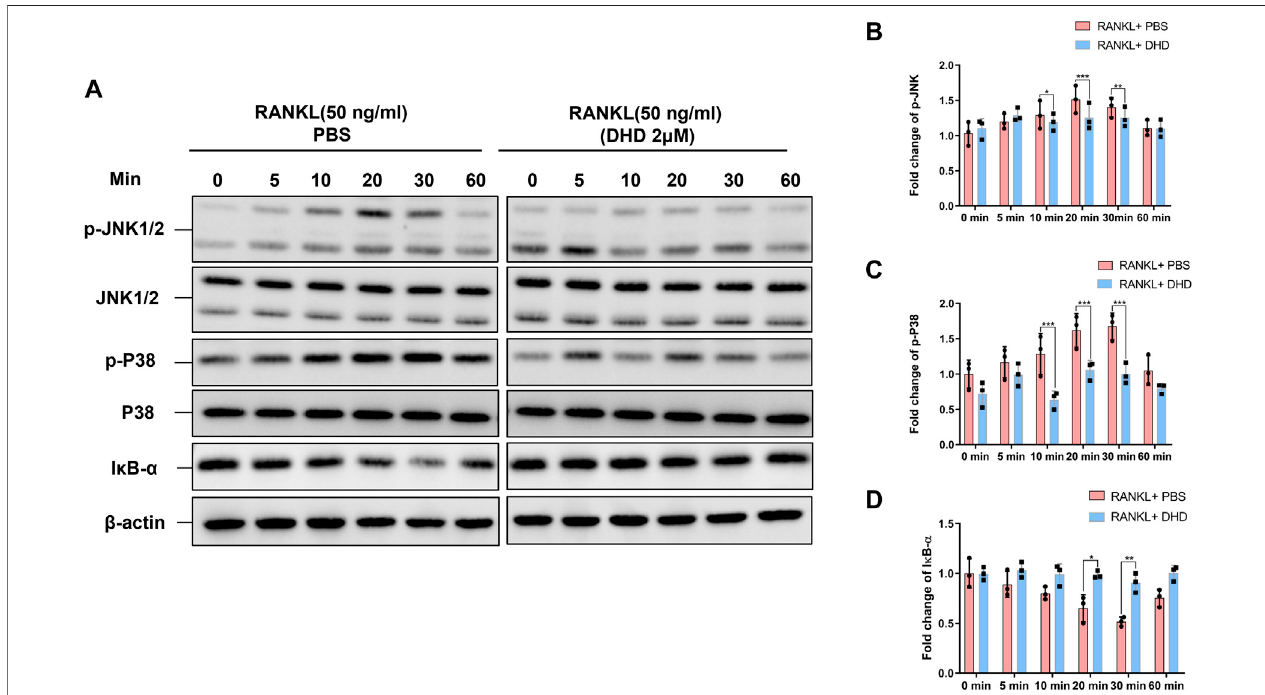
FIGURE 7 | DHD inhibits the RANKL-induced MAPK signaling pathways. (A) Representative Western blotting images of the effects of DHD on phosphorylation JNK1/2 and P38 and I κ B- α . DHD was used to pretreat BMMs for 1 h followed by 0, 5, 10, 20, 30, and 60 min of RANKL (50 ng/ml) stimulation. (B – D) Quantitative analysis of the fold change in p-JNK, p-P38, and I κ B- α expression after DHD (2 μ M) treatment.